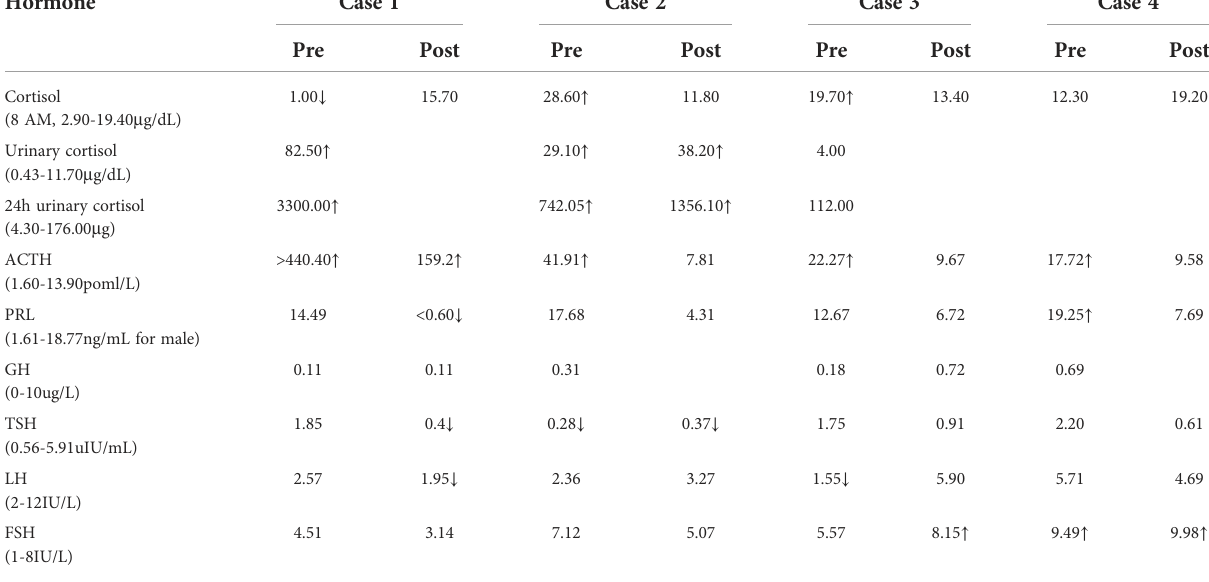
TABLE 2 Hormonal changes in displayed